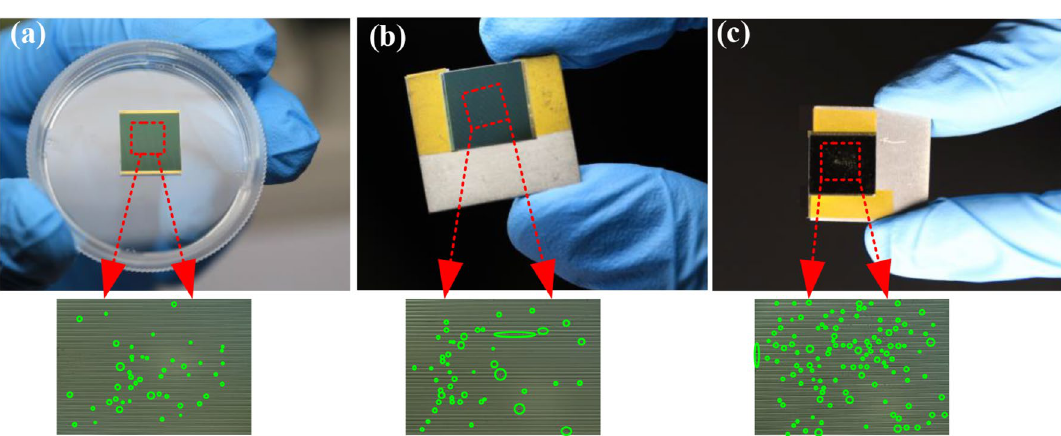
Figure 2. PV cells after impacted by particles with number densities of ( a ) N 1 = 35/mm 2 , v i = 65 m/s, ( b ) N 2 = 80/ mm 2 ,